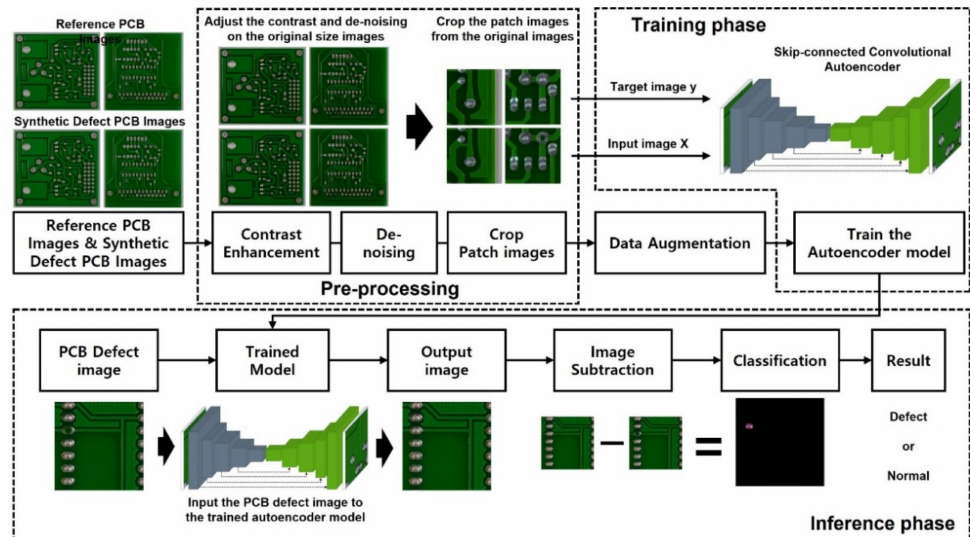
Figure 3. System overview of PCB defect detection (To enhance the quality of the data, we applied preprocessing to the PCB dataset. The quantity of the data for training is fulfilled by the data augmentation step, and all the data are inputted into our proposed autoencoder model. After the training, the trained model generates a non-defect image from the defect image, and image subtraction between these two images enables us to find the exact defect shape and